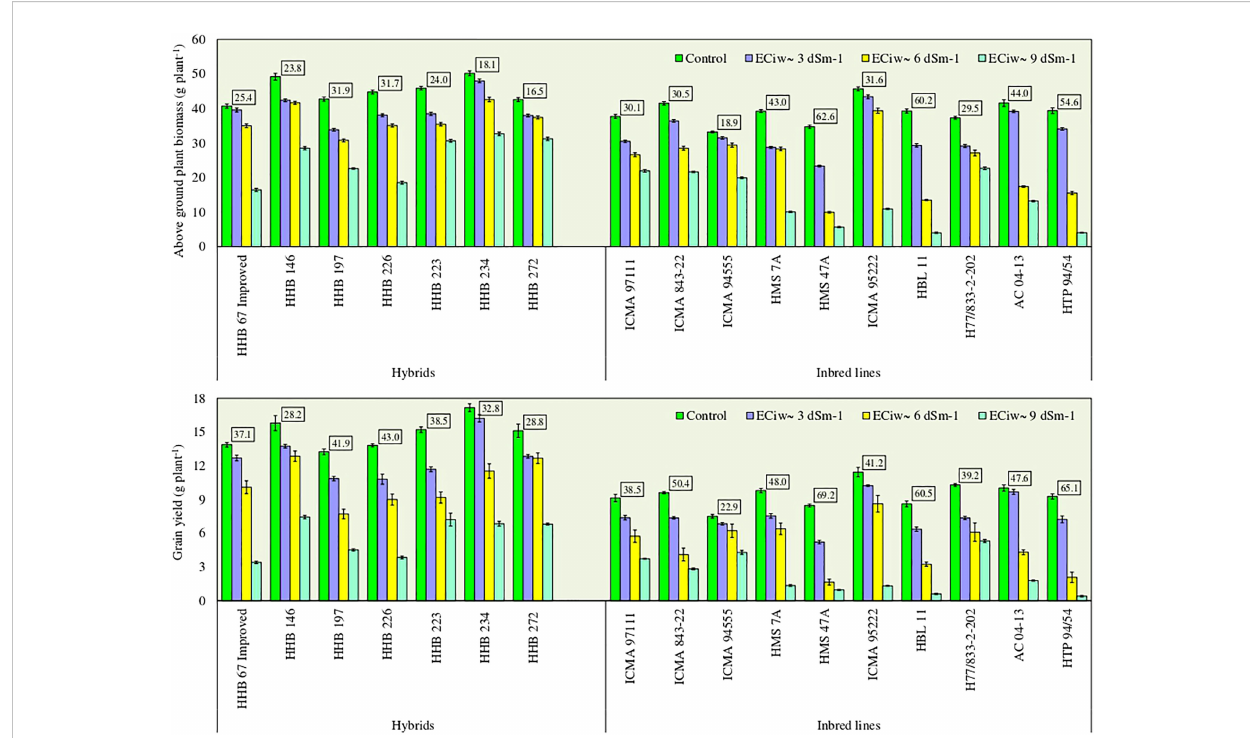
FIGURE 1 Effect of irrigation induced salinity stress on above ground plant biomass (AGB; g plant -1 ) and grain yield (GY; g plant -1 ) in pearl millet hybrids and inbred lines. Data represents mean value of 15 pooled measurements (3 plants per pot x 5 replications). Vertical bars labelled with boxes represent mean per cent reduction in AGB and GY due to salinity stress (averaged acrossed EC iw of 3, 6 and 9 dS m -1 ) in comparison to control treatment receiving best available water (EC iw -0.6 dS m -1 ). Capped lines represent ± standard error of the mean